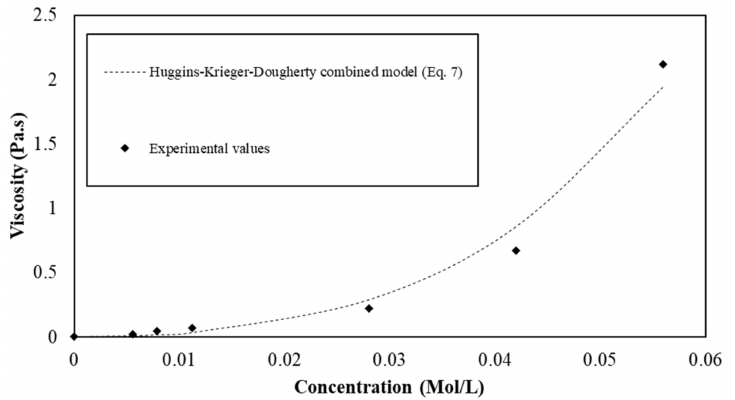
Figure 6. Viscosity of the s/s PCMs water suspension as a function of the s/s PCMs soluble part concentration. Table 5. Huggins–Krieger–Dougherty combined model